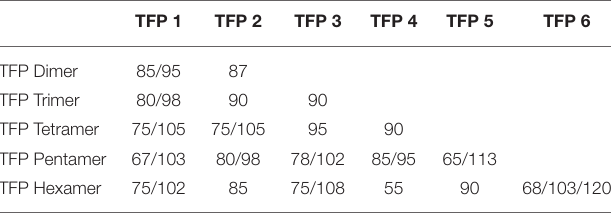
Distributions of the orientations for each oligomeric state are shown in Figure 8 .